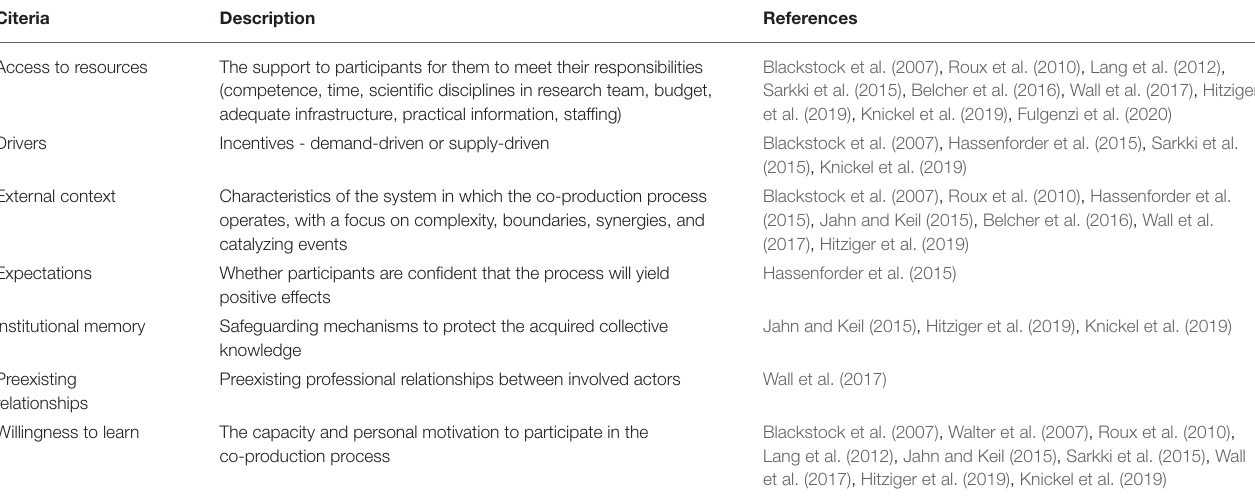
TABLE 2 | Criteria for evaluating co-produced knowledge – the enabling